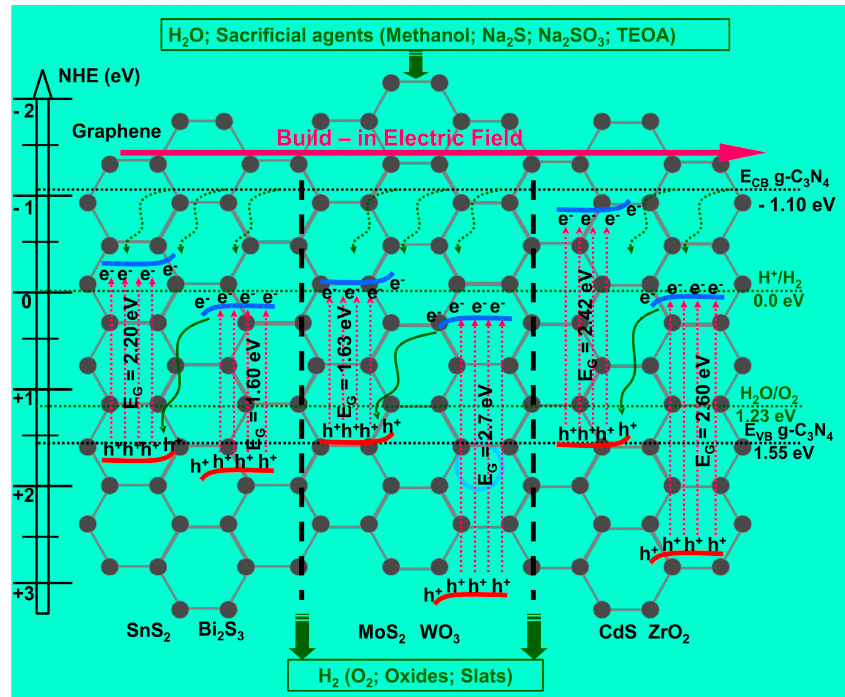
Figure 6. Energy band diagrams of SnS 2 /Bi 2 S 3 , MoS 2 /WO 3 , and CdS/ZrO 2 S-scheme heterostructures including the graphene structure (gray dots) and g-C3N4 band energy potential (black dots and lines).